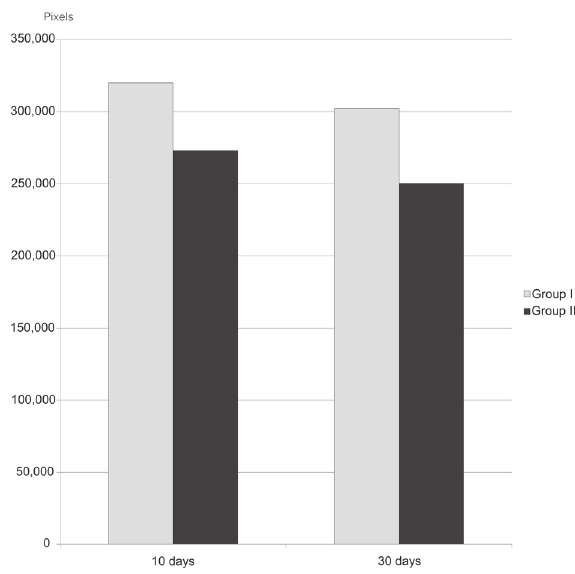
Figure 6- Area of the bone graft fragment in Groups I and II at 10 and 30